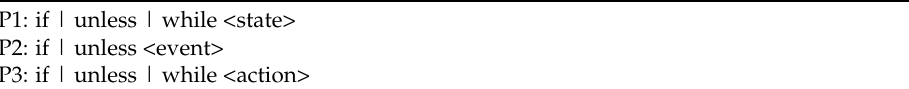
Table 4. Boilerplate Prefix Clauses (P i ).